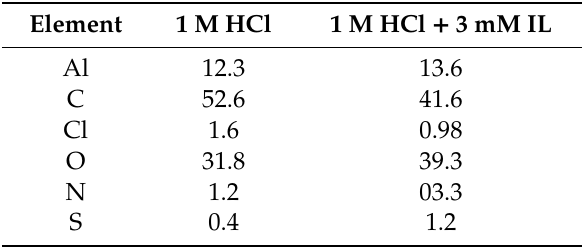
Figure 9. XPS peaks for passive films of the AA 6061 alloy exposed to 1 M HCl solution, ( a ) without inhibitor; ( b ) with 3.0 mM inhibitor. Table 4. Compositions of surface elements (at.%) from the XPS investigation for AA 6061alloy samples immersed in 1 M HCl without and with